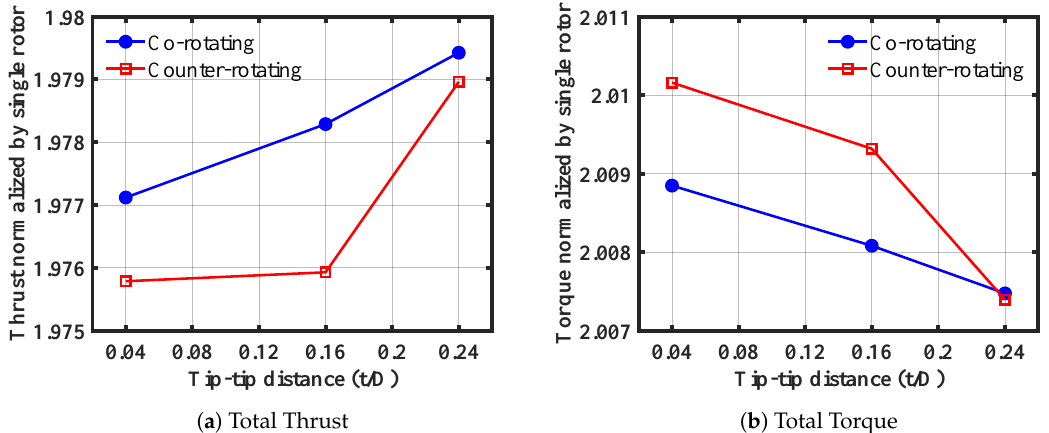
Figure 9. Helios predictions of the performance of the dual rotor systems operating at 6000 RPM in hover normalized by isolated rotor values.